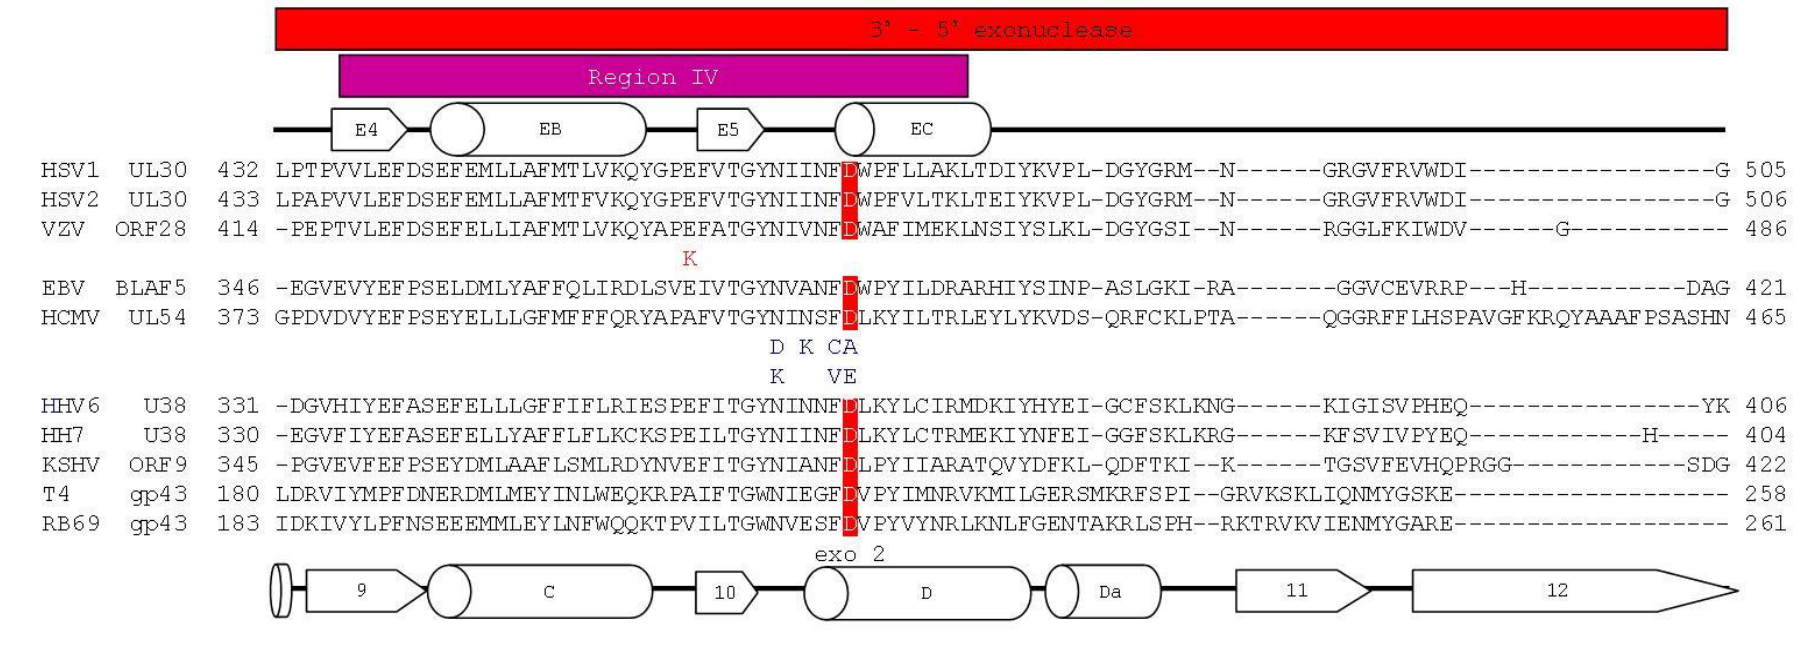
Appendix Figure A1.